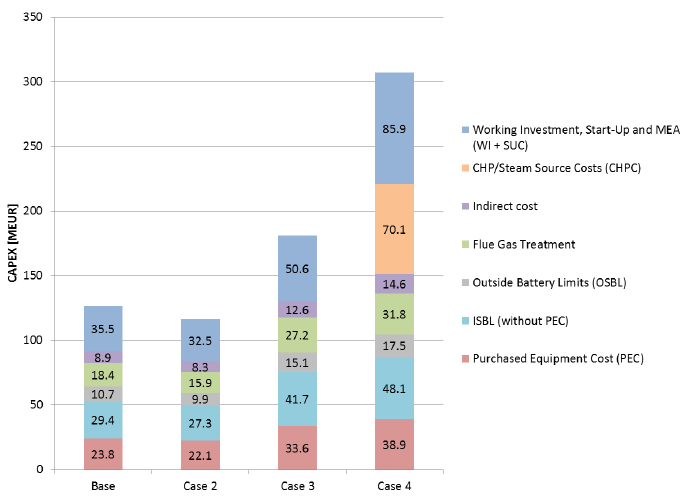
Figure A3. CAPEX for carbon capture in cement plants. Table A9. CAPEX results for carbon capture in cement plants in [MEUR].